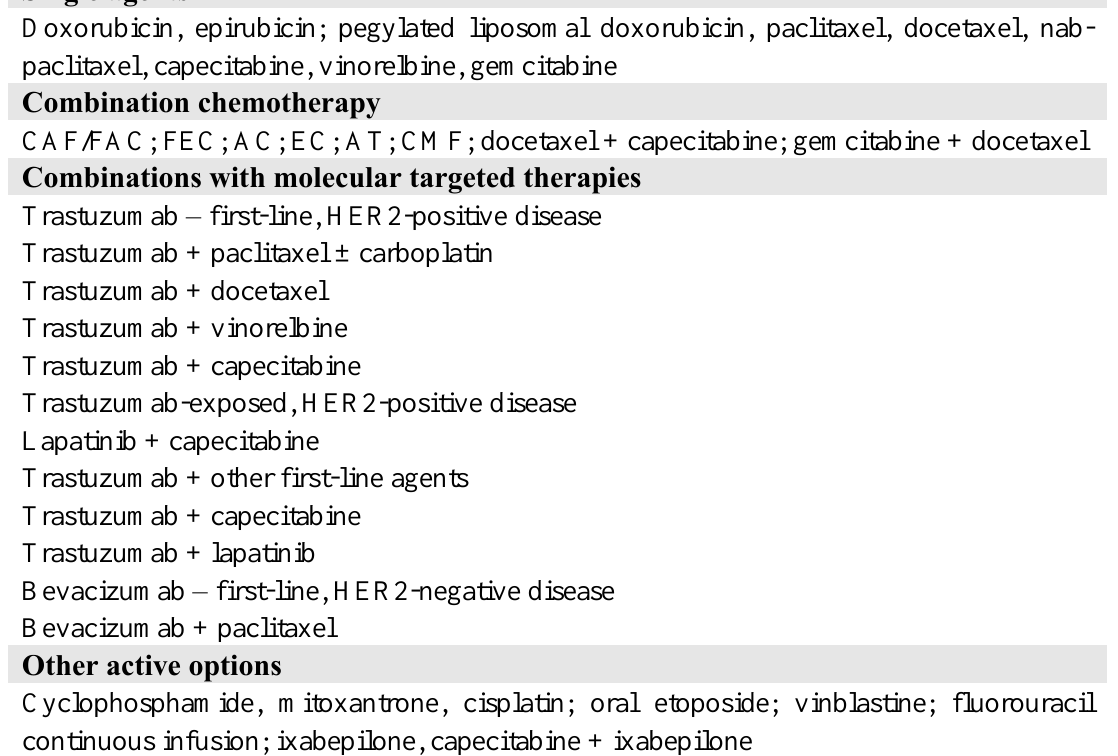
Table 1. Preferred chemotherapy agents and regimens for MBC